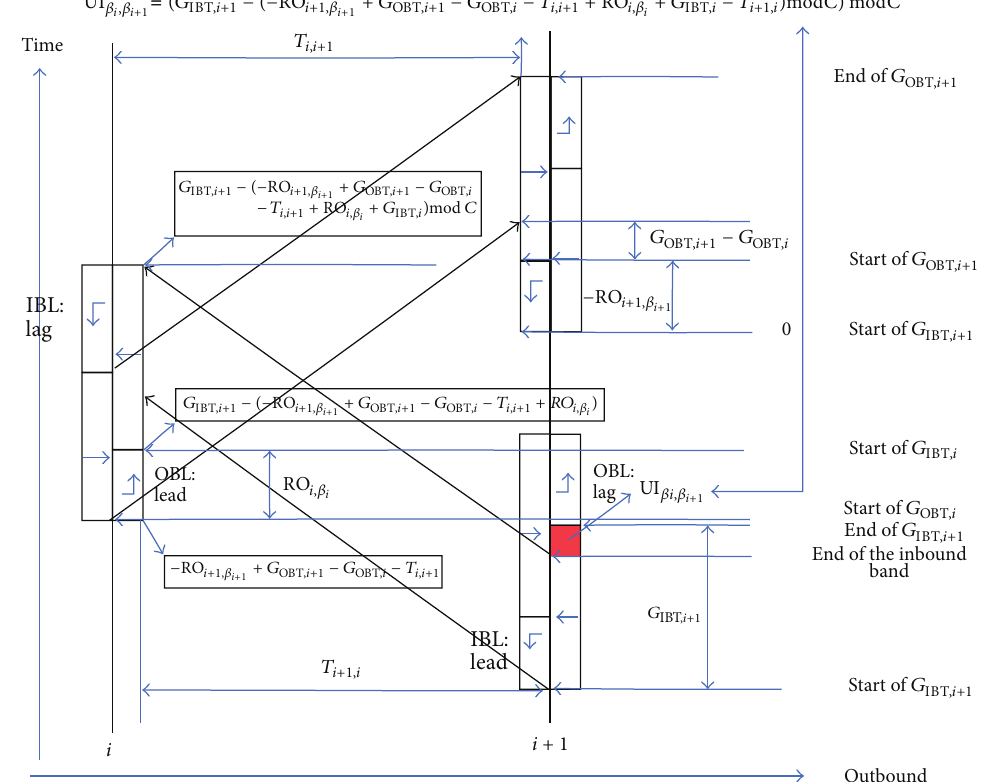
Figure 3: The calculation of upper interference for situation 4.